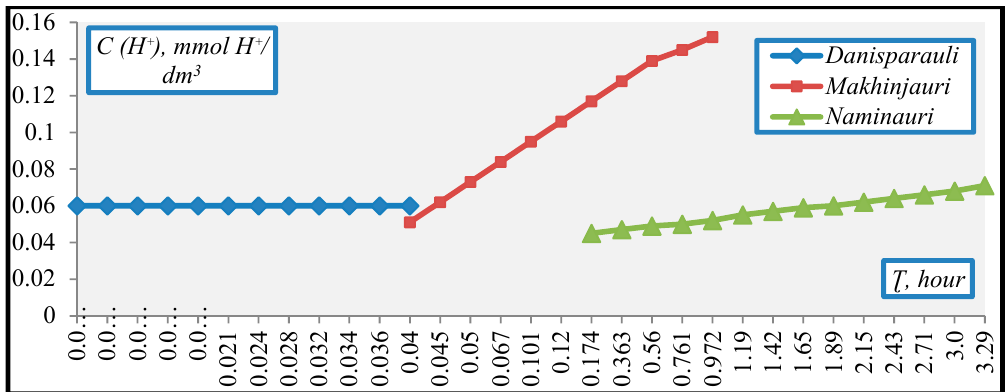
Figure 6. Change in titratable acidity C(H + ) of medicinal waters during ultrafiltration.